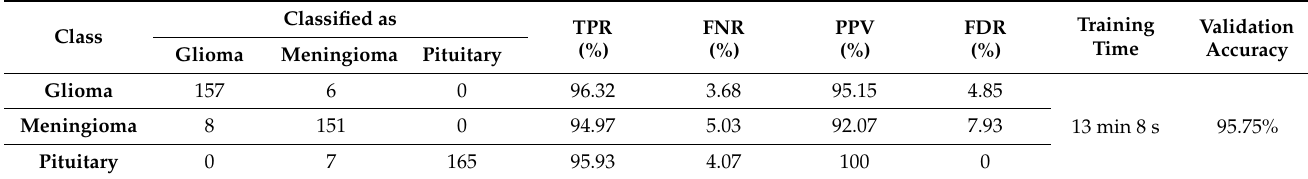
Figure 7. Results of testing of developed transfer-learned model for dataset-III. Table 5. Detection of type of brain tumor using developed transfer-learned network.